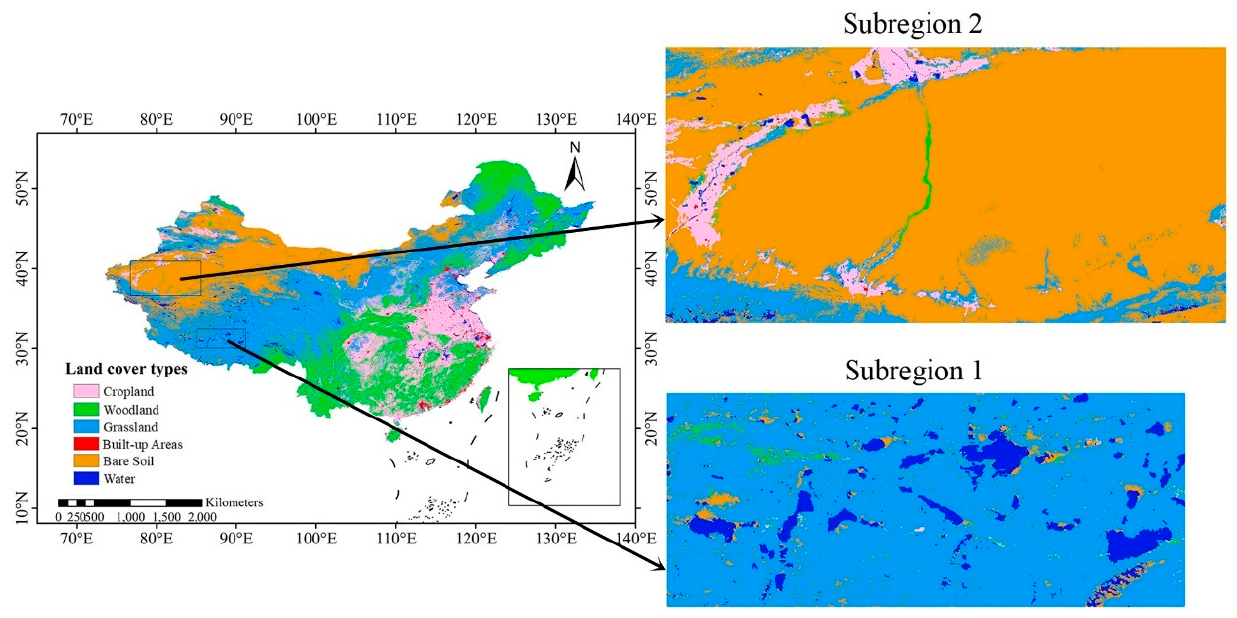
Figure 5. Two representative sub-regions for comparison in more detail.